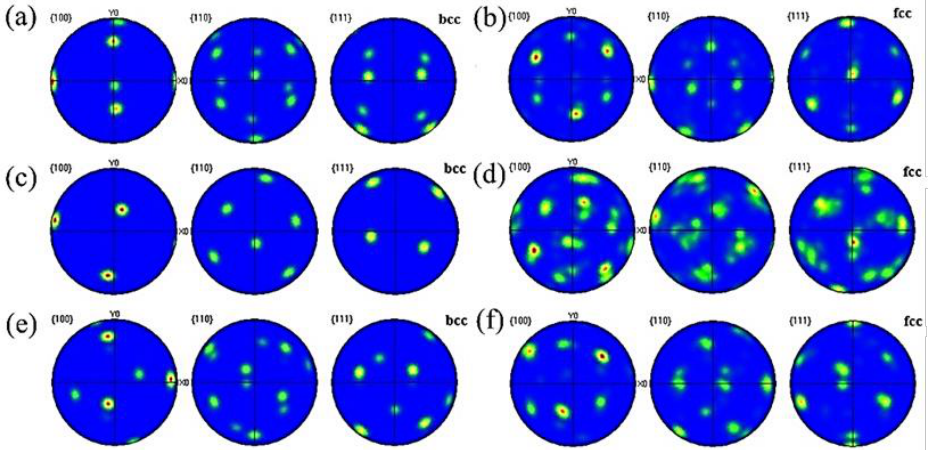
Figure 5. The pole figure of ferrite and austenite at different positions of the additive part: ( a , b ) bottom; ( c , d ) middle; ( e , f ) top.